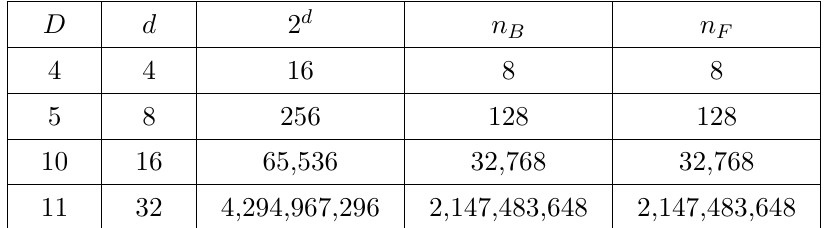
Table 1 . Number of independent components in unconstrained scalar super(cid:12)elds in D dimensional spacetime.